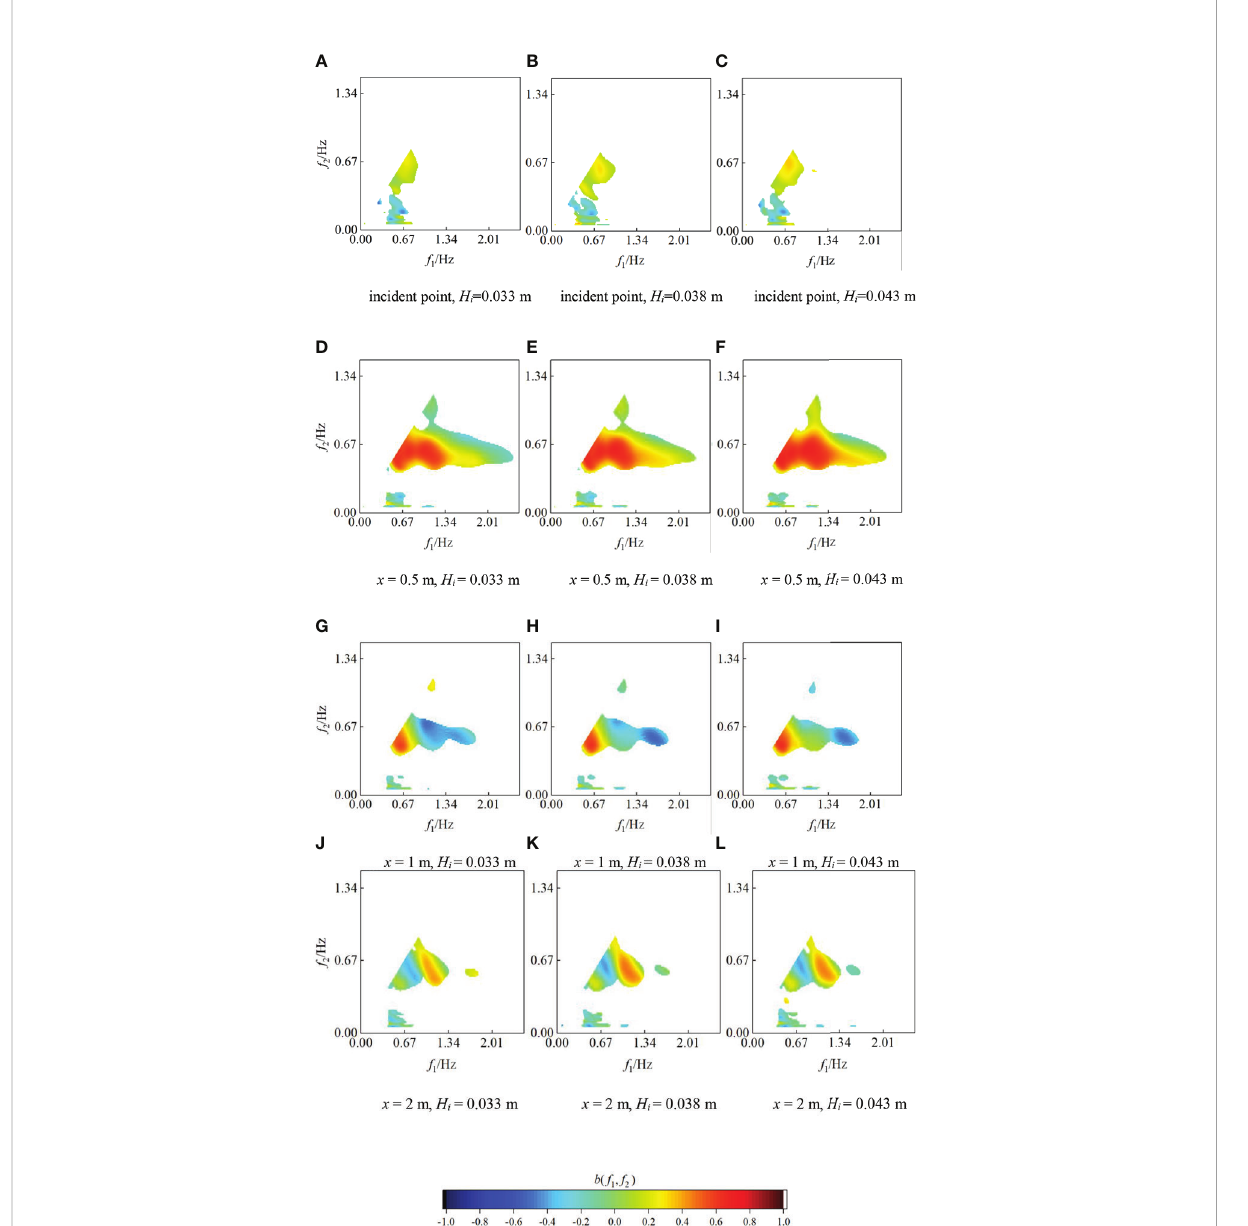
FIGURE 10 Changes in the wavelet-based bispectrum under different incident wave heights (M1, D = 0.28 m, T = 1.5 s) (A) incident point, H i =0.033 m (B) incident point, H i =0.038 m (C) incident point, H i =0.043 m (D) x = 0.5 m, H i = 0.033 m (E) x = 0.5 m, H i = 0.038 m (F) x = 0.5 m, H i = 0.043 m (G) x = 1 m, H i = 0.033 m (H) x = 1 m, H i = 0.038 m (I) x = 1 m, H i = 0.043 m (J) x = 2 m, H i = 0.033 m (K) x = 2 m, H i = 0.038 m (L) x = 2 m, H i = 0.043